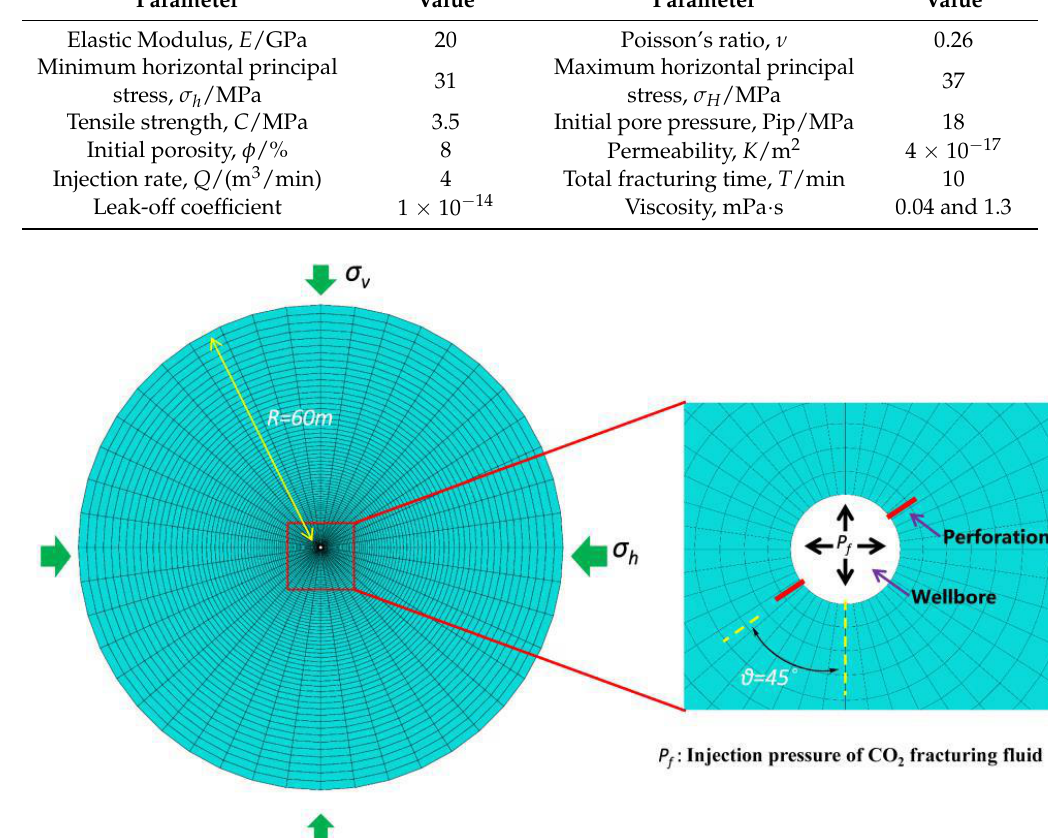
Figure 3. Schematic diagram of the established finite element